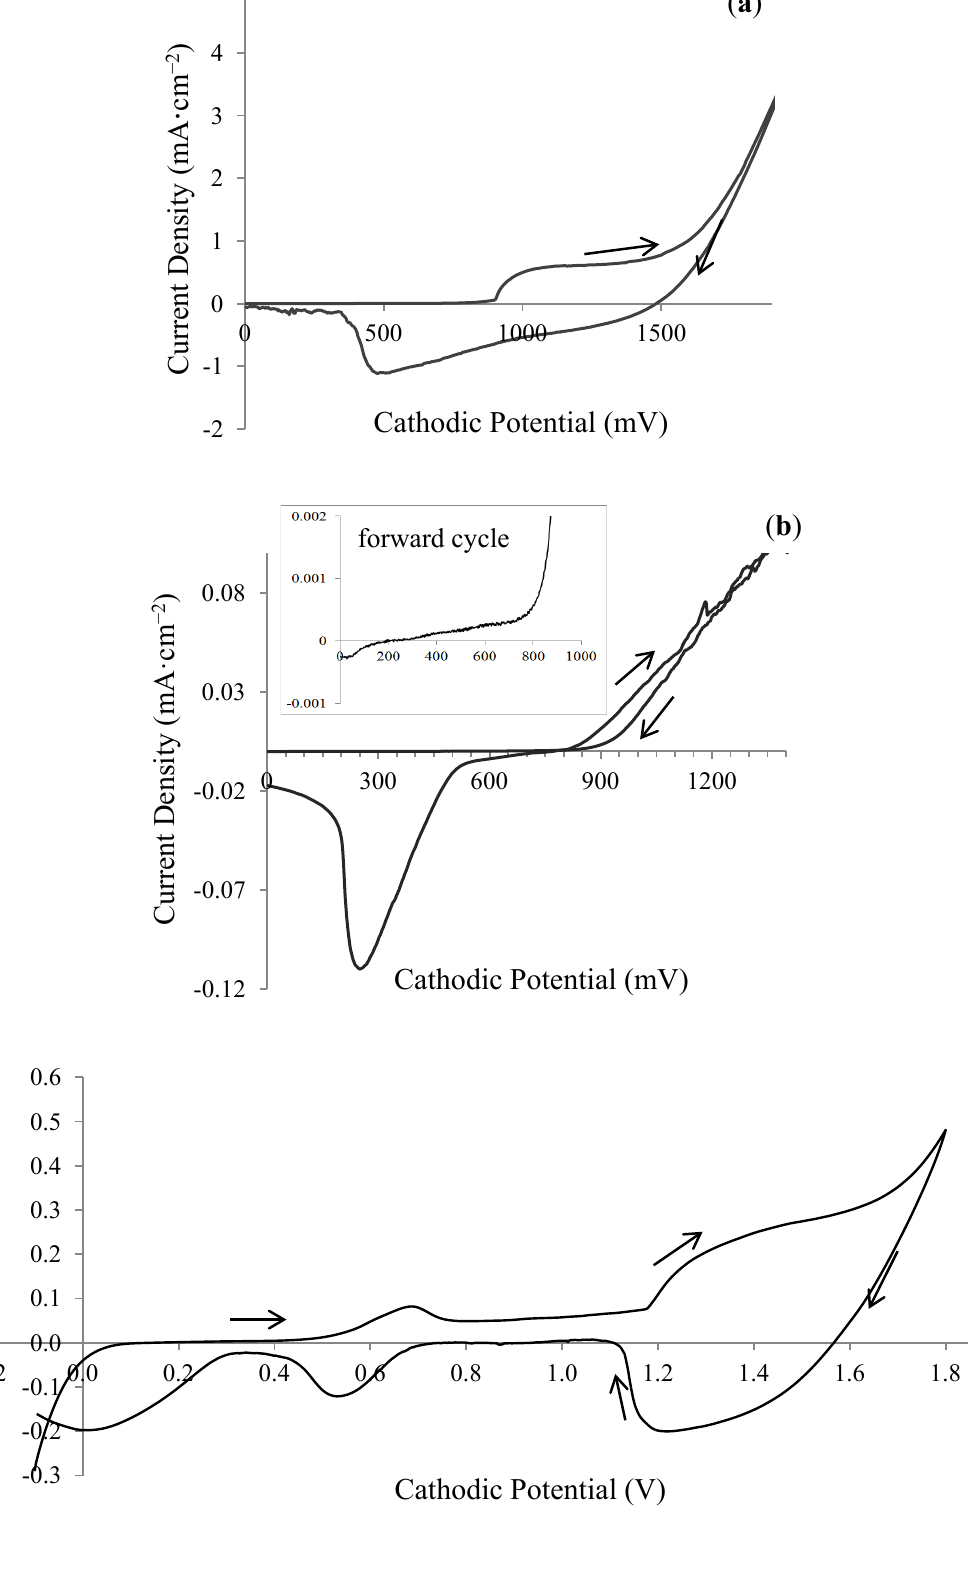
solution; ( b ) TeO solution; and 4 2 and TeO solutions. Inset 4 2